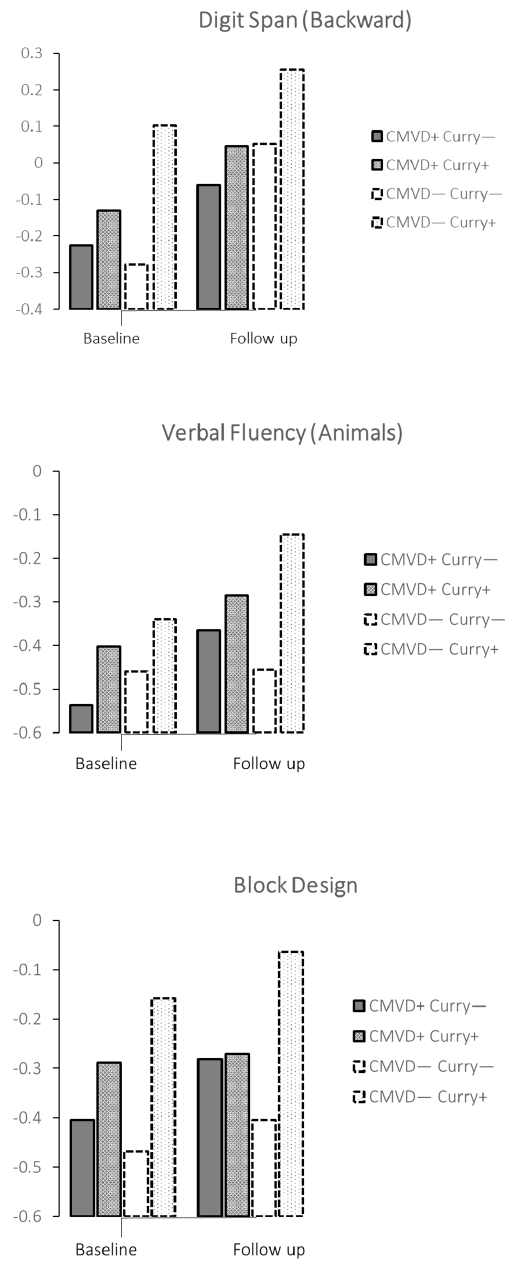
Figure 2. Significant associations between curry consumption and Digit Span (Backward), Verbal Fluency (Animals) and Block Design in subgroups of participants with and without cardiometabolic and vascular disease.